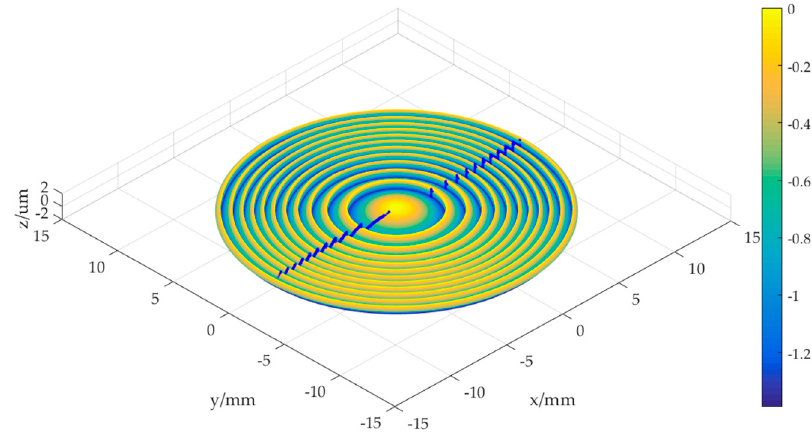
Figure 6. The e ff ect of the measured data matching the 3D design